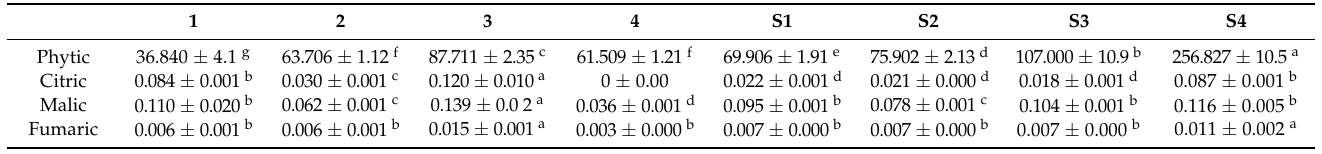
Table 2. Organic acid contents of fresh and stored white cabbage grown using different forms of sulfur fertilization (g · kg − 1